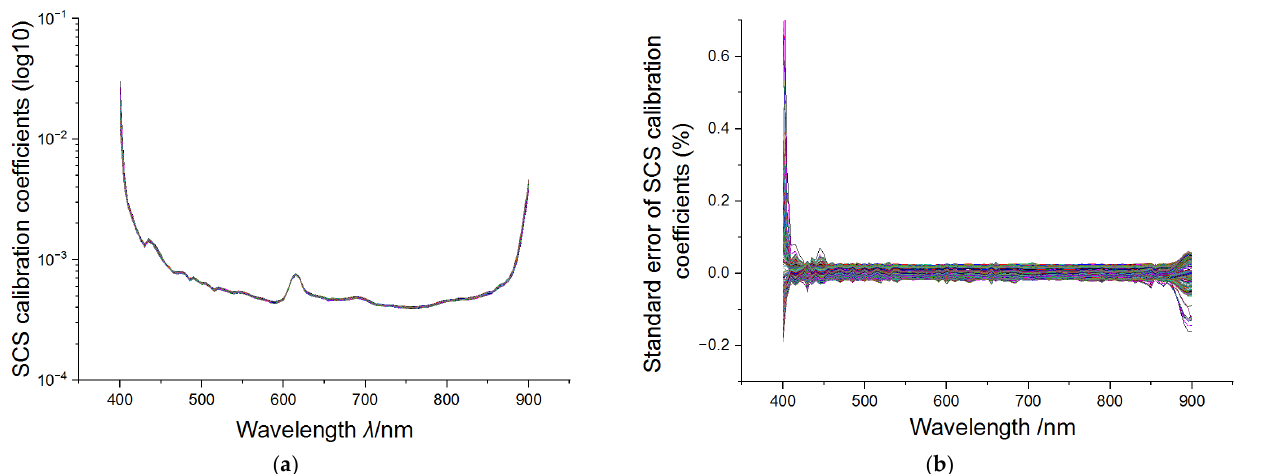
Figure 4. Onboard calibration coefficients of all SCS visible and near infrared spectral bands and their relative standard deviations. ( a ) Calibration coefficients of all SCS VIS-NIR spectral bands and ( b ) their relative standard deviation.